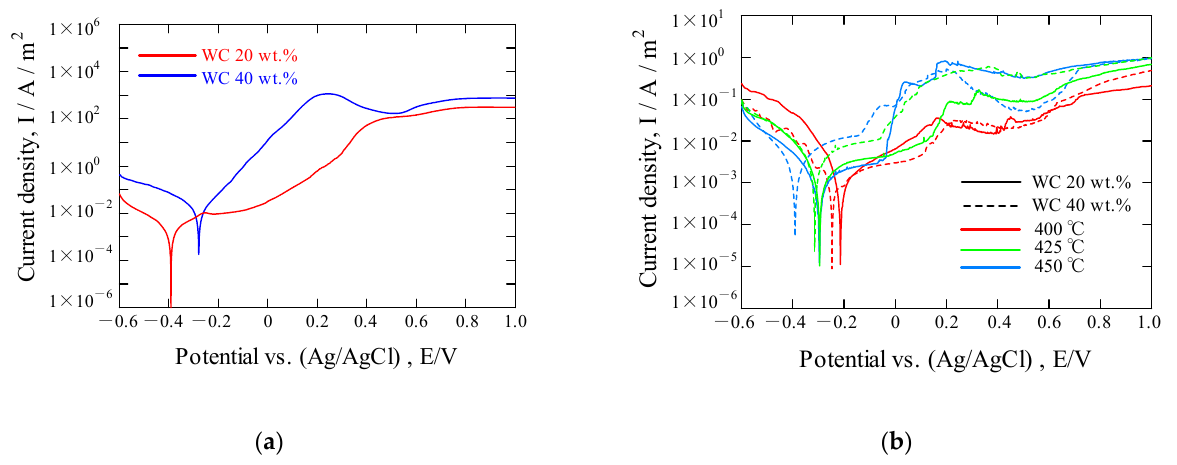
Figure 9. Anodic polarization curves in 3.5 mass% NaCl solution of the as-deposited and nitrided layers with various WC compositions and nitriding temperatures: ( a ) of as-deposited layers, and ( b ) of nitrided